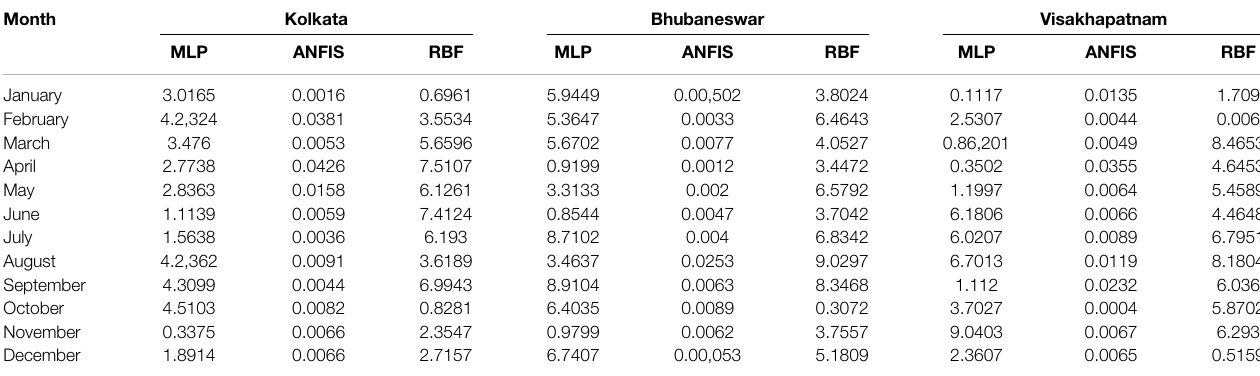
TABLE 9 | Absolute relative error for the three cities mentioned with soft computing methods.